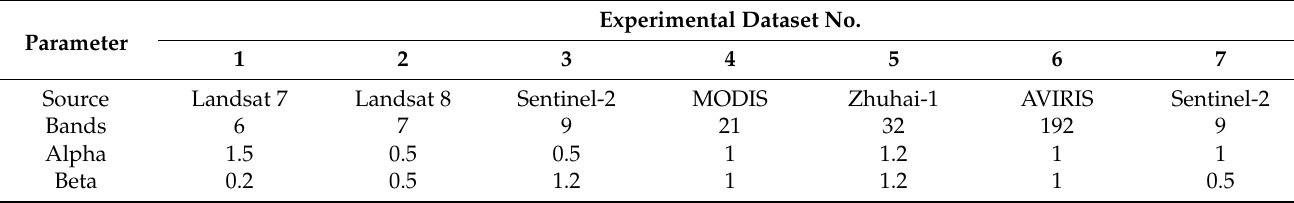
Table 3. The parameters of the MSE method with SSI for the experimental datasets. Experimental Dataset Parameter